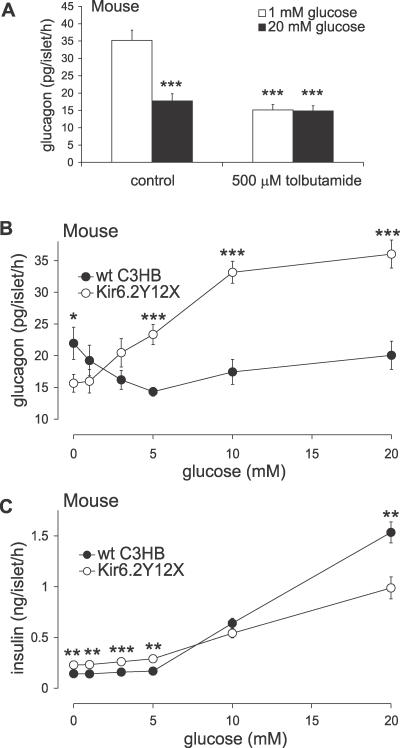
Tolbutamide and Glucose Effects Are Non-Additive and Glucagon Response Is Altered in Kir6.2Y12X Islets That Express a Truncated Kir6.2 Subunit(A) Glucagon release from isolated mouse islets at 1 (open bars) and 20 mM glucose (filled bars) under control conditions and presence of 0.5 mM tolbutamide.(B) A glucose dose-response of glucagon release from control C3HB islets (filled circles) and Kir6.2Y12X islets (open circles).(C) As in (B), but insulin was measured.*, p < 0.05; **, p < 0.01; ***, p < 0.001, compared with control.